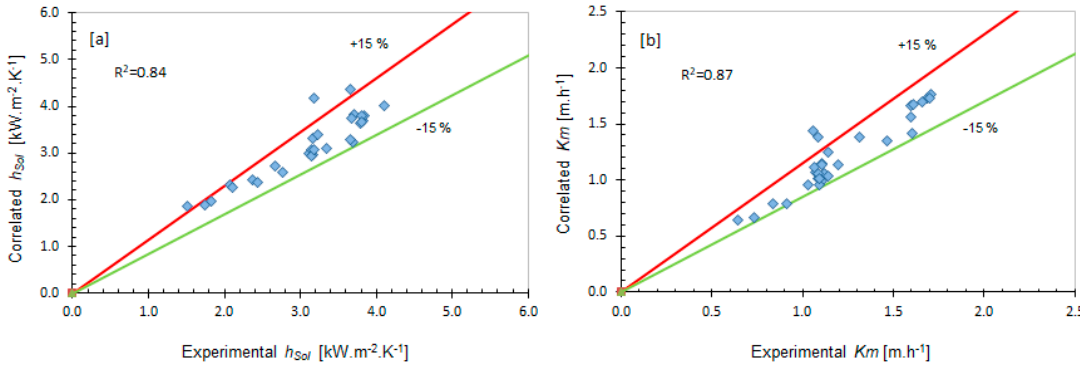
Figure 4. Predicted data vs. experimental data in the H-type PHE for ( a ) solution-side heat transfer coefficient; and ( b ) solution-side mass transfer coefficient.